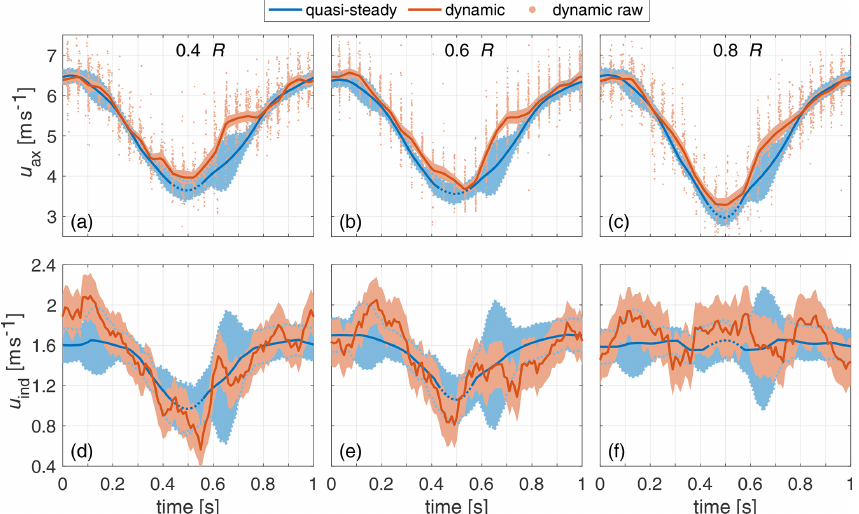
Figure 9. Quasi-steady and dynamic axial velocity and induced velocity for sine wind field at radii 0.4 R (a, d) , 0.6 R (b, e) and 0.8 R (c, f) . The 95% CIs are given, and errors for the quasi-steady case and the induced velocity of the dynamic case were quadratically added. Note that the reference velocity values for the quasi-steady and dynamic induced velocity slightly